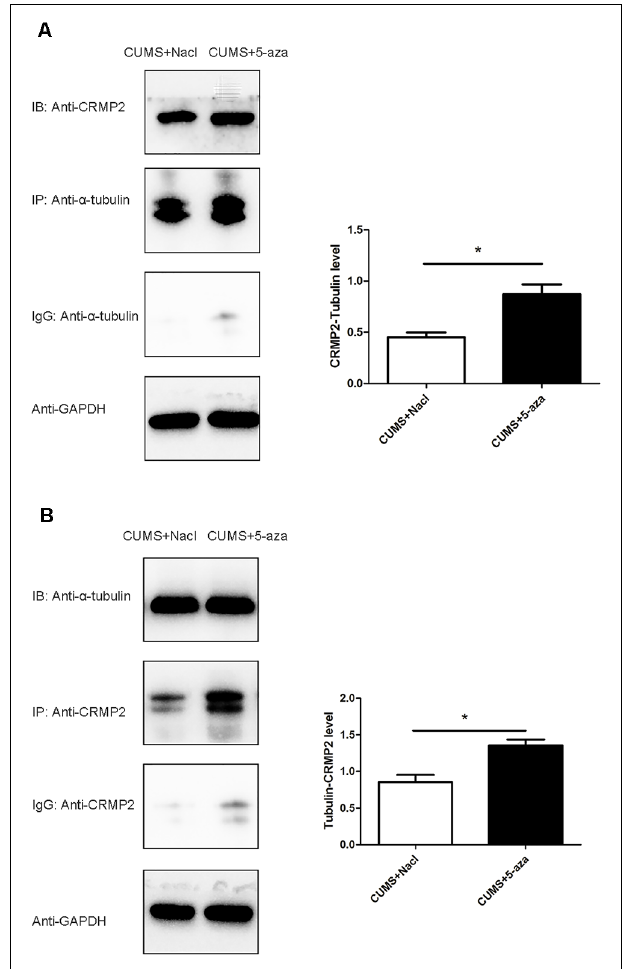
FIGURE 9 | Effect of 5-aza treatment on the interaction between CRMP2 and α -tubulin (A,B) . * P <